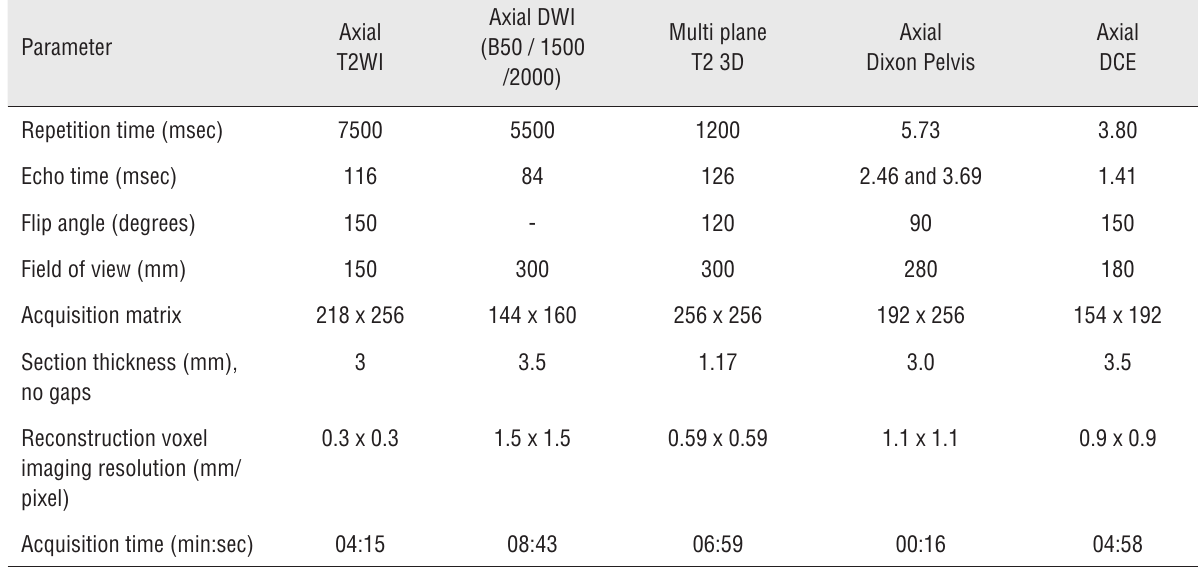
Table 1 - Sequence parameters of prostate